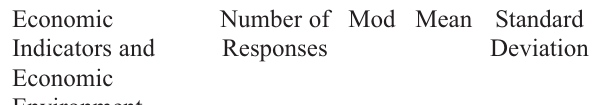
Table 5 . Motives for Foreign Direct